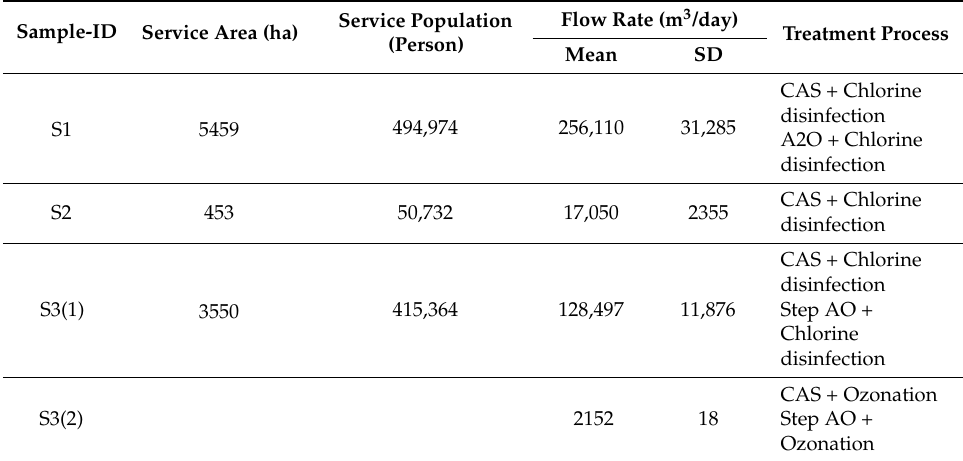
Figure 1. Locations of sampling sites in the Kanzaki–Ai River basin (reproduced from [30]). (Information of the sampling sites of S1–S3 are shown in Table 1, while those of a combined group of R1–R6 and T1–T4 are shown in Table 2.). Table 1. Information of sewage treatment plants (STPs) located in the Kanzaki–Ai River basin (Figure 1) (reproduced from the data in [30]).